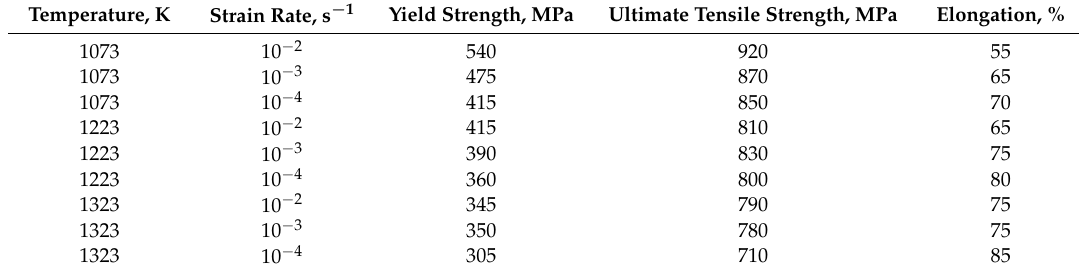
Figure 7. Engineering stress vs. elongation curves for a high-Mn steel subjected to hot compression at the indicated conditions. Table 1. Some mechanical properties of a high-Mn steel processed by hot compression at the indicated temperatures and strain rates.